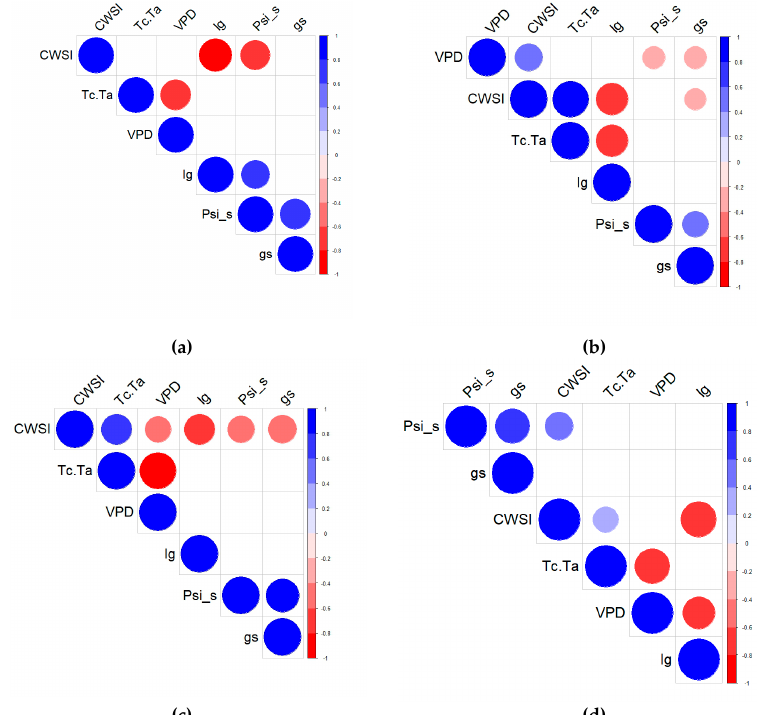
Figure 4. Correlation map (correlogram) of remotely-sensed thermal indices (CWSI, I g , (T c -T a )) along with environmental conditions (VPD) and vine water status (g s , Psi_s or Ψ s ) for two cultivars and timepoints for the 2016 (S1) growing season: SHI veraison (a) , CAS veraison (b) , SHI pre-harvest (c), and CAS pre-harvest (d) . Only significant Pearson correlation coefficients ( p ≤ 0.05) are shown. Blue circles correspond to significant positive correlations and red circles to significant negative correlations. The size of the circle reflects the magnitude of the Pearson correlation coefficient. In 2017, g s of SHI at veraison positively-correlated with I g (R 2 =0.60, p =0.0244) and negatively- correlated with CWSI ( R 2 = − 0.63, p = 0.0163) and ( T c - T a ) ( R 2 = − 0.62, p = 0.0174) (Figure 5a). For CAS, g s negatively-correlated with CWSI ( R 2 = − 0.38, p = 0.0170) and ( T c - T a ) ( R 2 = − 0.31, p = 0.0481) (Figure 5b). At pre-harvest, SHI Ψ s was negatively-correlated with CWSI ( R 2 = − 0.37, p = 0.0254) and ( T c - T a ) ( R 2 = − 0.54, p = 0.0001), while g s also negatively-correlated with ( T c - T a ) ( R 2 = − 0.44, p = 0.0095) (Figure 5c). For CAS at pre-harvest, g s was negatively-correlated with CWSI and ( T c - T a ) ( R 2 = − 0.39, p = 0.0027 for CWSI ; R 2 = − 0.36, p = 0.0063 for ( T c - T a )), and Ψ s was negatively-correlated with I g ( R 2 = − 0.31, P = 0.0198) (Figure 5d). Overall, the relationships between the conventional vine water status parameters, Ψ s and g s , appeared to be stronger with CWSI in the warmer, drier season (2016) compared to the cooler, wetter season (2017) when I g and ( T c - T a ) showed stronger correlations.